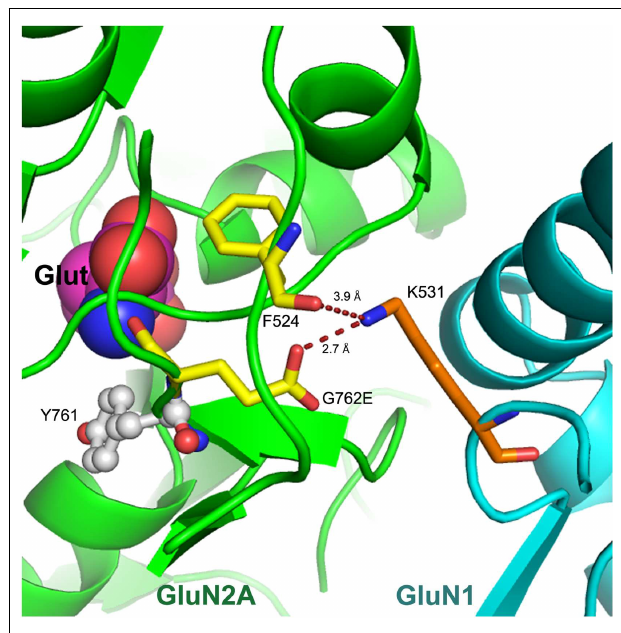
FIGURE 2 | Model of G762E within the GluN1–GluN2A X-ray crystal structure .The S1S2 loop of GluN2A (in green) is shown interfacing with GluN1 (in cyan). A portion of the GluN2A agonist-binding site is on the left together with bound glutamate (Glut). G762E and F524 residues of GluN2A are 2.7 and 3.9Å away from K531 in GluN1, respectively; potential new electrostatic interactions are indicated as dashed lines. Nitrogen atoms are in blue, and oxygen in red.